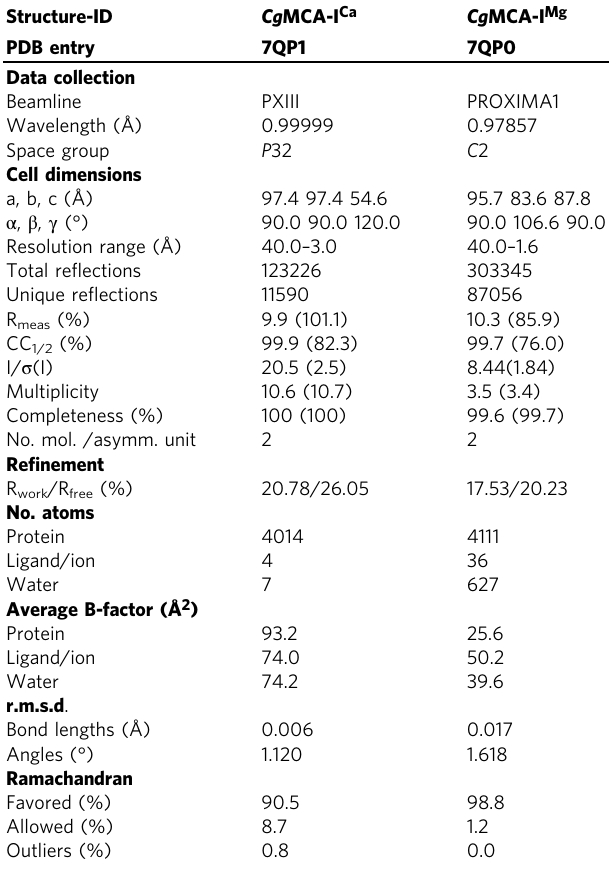
Table 1 Data collection and re fi nement